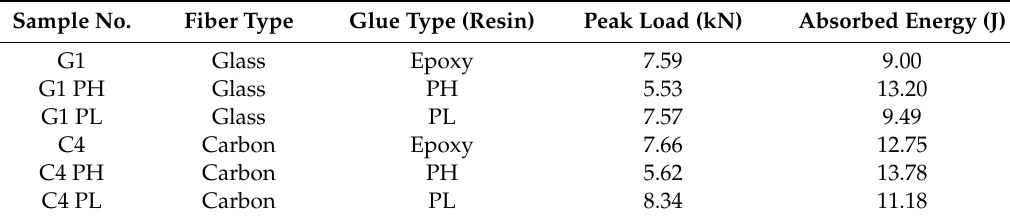
Table 6. Low-velocity impact test conditions and results for glass- and carbon-fiber plates with different resins.